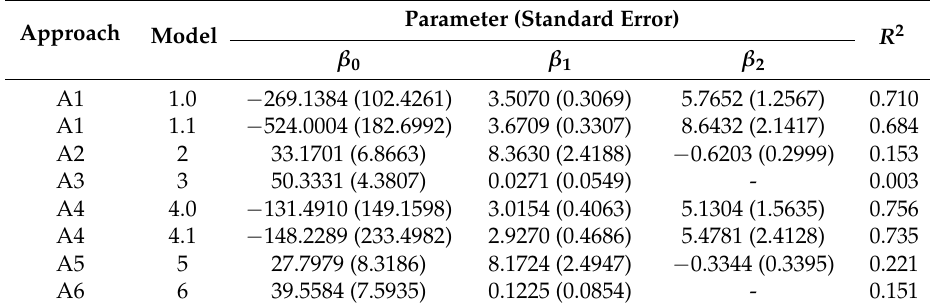
Table 4. Parameter estimates and their standard errors of the models used to predict volume per hectare and its change using lidar variables. Model 1.0 and Model 1.1 predicted volume per hectare in 2007 and 2012, respectively, using the fixed effects model. Model 4.0 and 4.1 did the same based on the mixed effects model. All other models predicted the change in volume per hectare, directly.